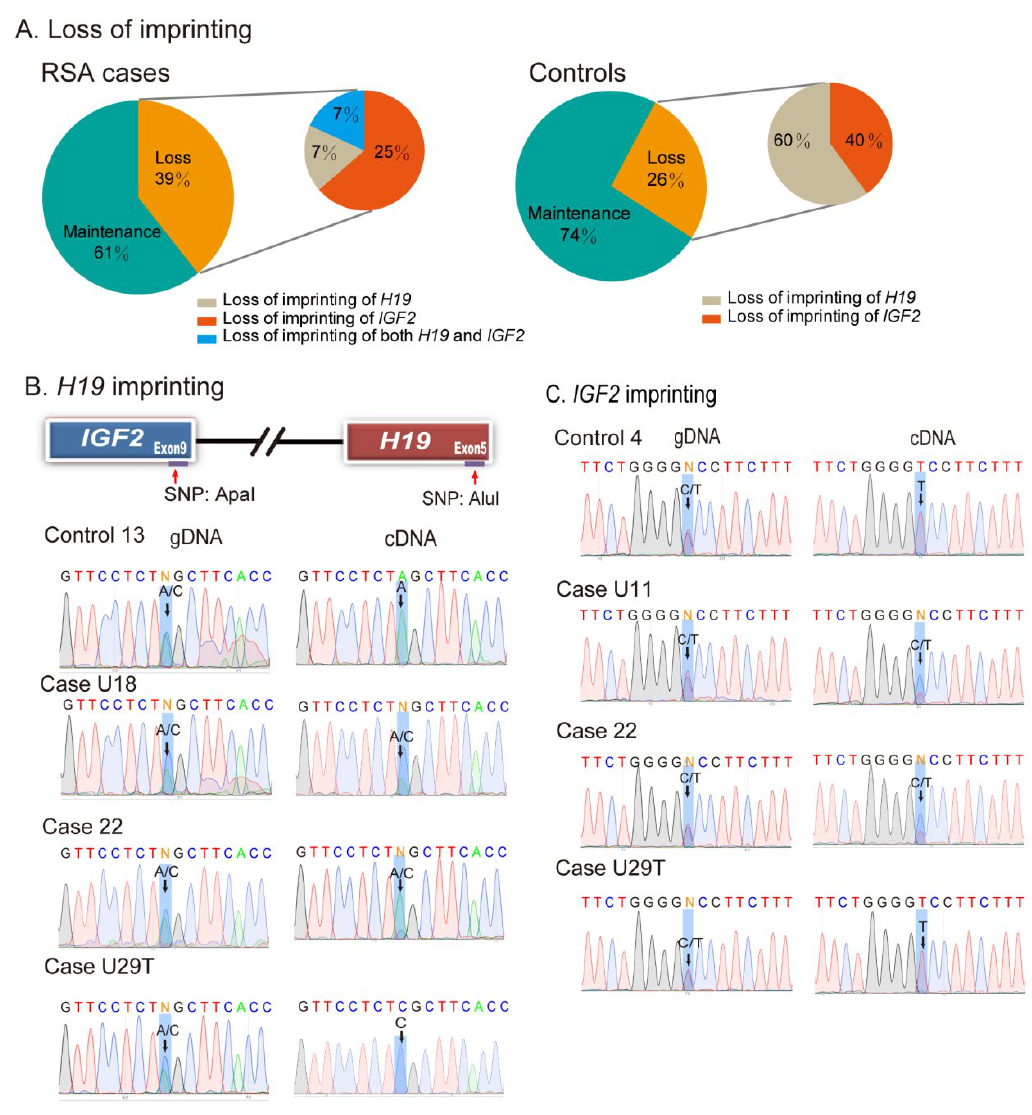
Figure 2. Loss of H19 / IGF2 imprinting in decidual tissues in RSA. ( A ) Percentage of abnormal H19 / IGF2 imprinting. Among the decidual tissues that are Apa1-informative, 39% cases in RSA cases and 26% in control subjects show the loss of either H19 or/and IGF2 imprinting. ( B ) Example of aberrant H19 allelic expression in RSA cases. Genomic DNAs (gDNA) of both cases U18 and M22 are Apa1 SNP informative (A/C alleles). In the cDNA samples, both parental alleles are expressed in decidual tissues. ( C ) Loss of IGF2 imprinting in RSA. In control 4, only the T allele is expressed. However, in cases U11 and M22, decidual cDNAs show biallelic expression of IGF2 .